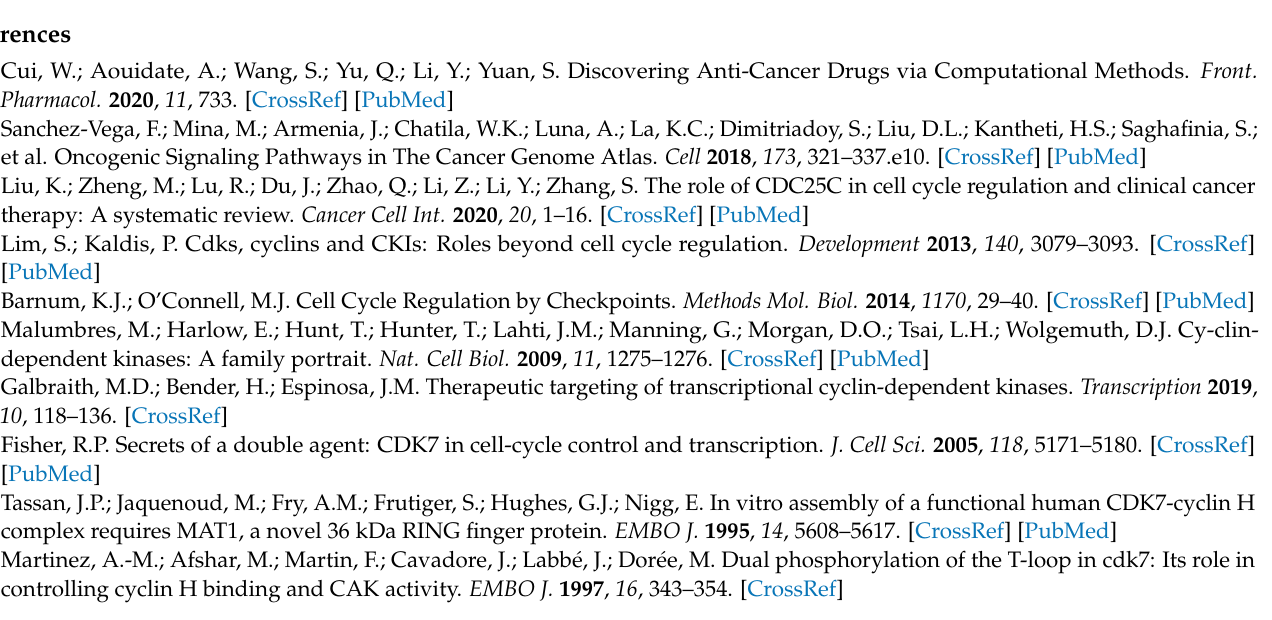
grey color ribbon representation, and the ligands are shown with stick representation. Only polar hydrogen atoms are shown for clear visualization. Figure S5. The 2D molecular interactions of the reference inhibitors and identified hits with CDK2 crystal structure bound with CT7001 (PDB ID: 5JQ5). The dark green dashed lines indicating hydrogen bonds, light green: van der Waals, purple: π -sigma, red: unfavorable acceptor–acceptor, orange: π -cation, while the π - π and π -alkyl interactions are shown in pink. Figure S6. Sequence alignment of CDK7 (PDB ID: 6XD3) and CDK2 (PDB ID: 5JQ5) resulted in 44.4% identity and 67.1% similarity. The red boxes are used to show the differences between the active site and outside the active site residues (309–312) of both the proteins. The degree of identity ranges from dark cyan color (identical) to white color (non-identical). Table S1. Ligand-based pharmacophore validation using receiver operating characteristic (ROC) curve. Table S2. Structure-based pharmacophore validation using receiver operating characteristic (ROC) curve. Table S3. Details of different properties used for generation of drug-like database. Table S4. List of potential compounds obtained after molecular docking. A total of 13 compounds show a better GoldScore than reference (REF) inhibitor. The binding free energies obtained after MD simulation are also shown. Table S5. List of potential compounds obtained after molecular docking. A total of 11 compounds show better GoldScore than REF inhibitor. The binding free energies obtained after MD simulation are also shown. Table S6. Molecular docking and molecular dynamics simulation analysis of hits and reference inhibitors against CDK7. Table S7. Molecular interactions of reference inhibitors and hits with CDK7 active site residues acquired from stable molecular dynamics simulation trajectories. Table S8. The molecular docking scores of hits and reference inhibitors with CDK2 and